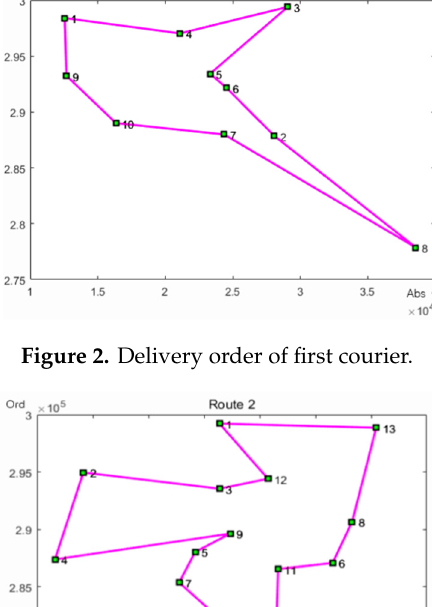
Figure 2. Delivery order of first courier.